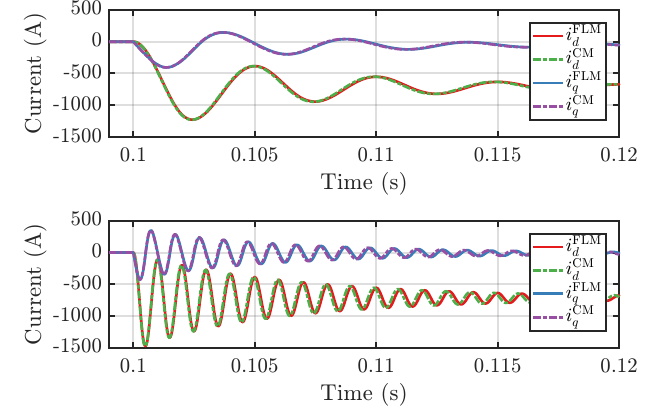
Figure 9. Comparison of FLM and CM for a three-phase symmetric short circuit at ( top ) 3000min − 1 and ( bottom ) 15,000 min − 1